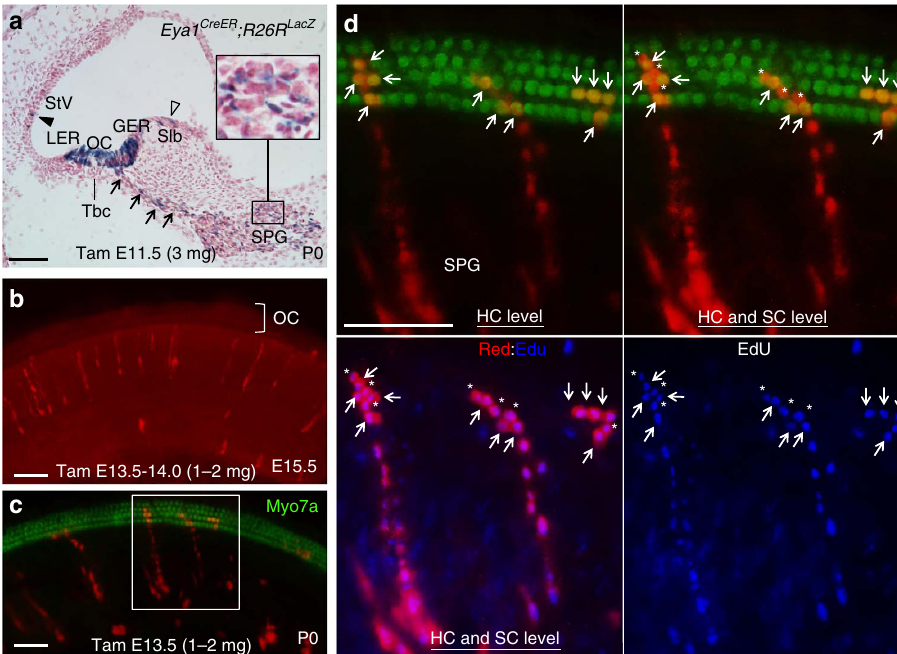
Figure 6 | Characterization of multipotent progenitors in the cochlea using Eya1 CreER mice. ( a ) LacZ staining on sections of P0 Eya1 CreERT2 ;R26R LacZ cochlea given tamoxifen (3mg) at E11.5 showing LacZ þ cells in the spiral ganglion (SPG), spiral nerve fibres projecting towards the organ of Corti (arrows), organ of Corti (OC) and flanking nonsensory lesser epithelial ridge and GER, in the stria vascularis (Stv) (solid arrowhead) and interdental cells in the spiral limbus (Slb) (open arrowhead). Tbc, tympanic border cells. ( b ) Short-term tracing showing no Eya1 -lineage marked clonal clusters in the OC of cochlea at E15.5 treated with tamoxifen from E13.5 to E14.0 (1–2mg). ( c ) Immunostaining for Myo7a (green) of Eya1 CreERT2 ;Rainbow cochlea at P0 after a single co-injection of tamoxifen (1–2mg) and EdU (30mgkg (cid:2) 1 body weight) at E13.5. ( d ) Higher magnification of boxed area in c showing three red clones in cochleae: two consisting of Myo7a þ HCs (arrows) and Myo7a (cid:2) SCs (asterisks) in the OC and cells in the region medial to the OC, which may consist of both GER cells and SPG cells and one (on the right) consisting of marked HCs (arrows) and SC (asterisk) but no connection to cells medial to the OC. All marked individual cells within each single clonal cluster were EdU þ . Images either focussed on HCs to show co-labelling of Myo7a and RFP or merged from Z -stack to also reveal surrounding SCs. Scale bars: 50 m